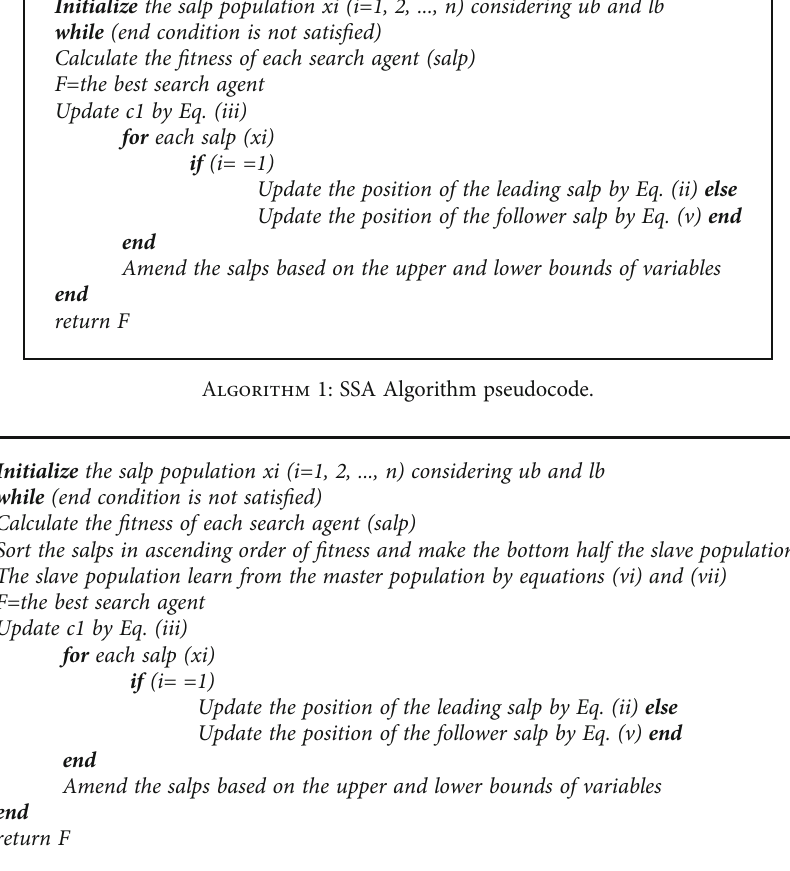
Algorithm 2: MSSSA